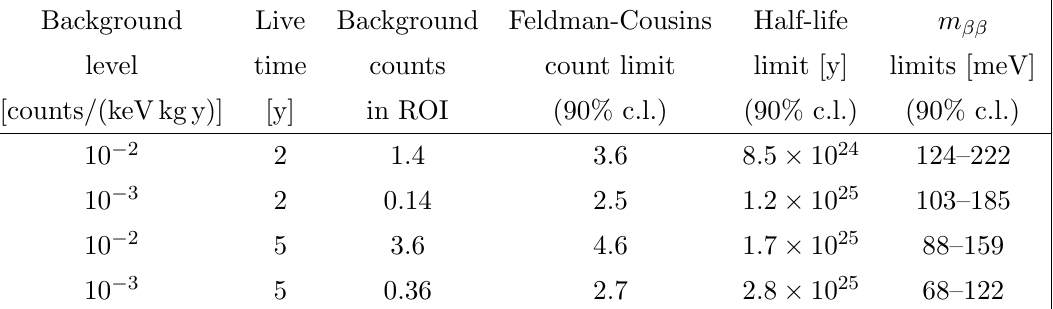
Table 3 . Sensitivity of the CROSS demonstrator to be operated in the cryogenic facility of the Canfranc underground laboratory, under two di(cid:11)erent hypotheses of background level. The region of interest is 8 keV. The e(cid:14)ciency is 75%, compatible with the crystal size of each element. The interval of limits on the e(cid:11)ective Majorana neutrino mass m (cid:12)(cid:12) accounts for a recent compilation of nuclear-matrix-element